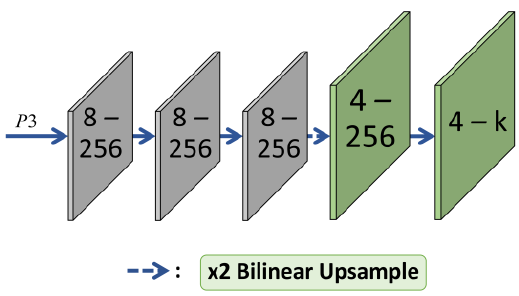
Figure 7. Mask head in Key-Yolact.